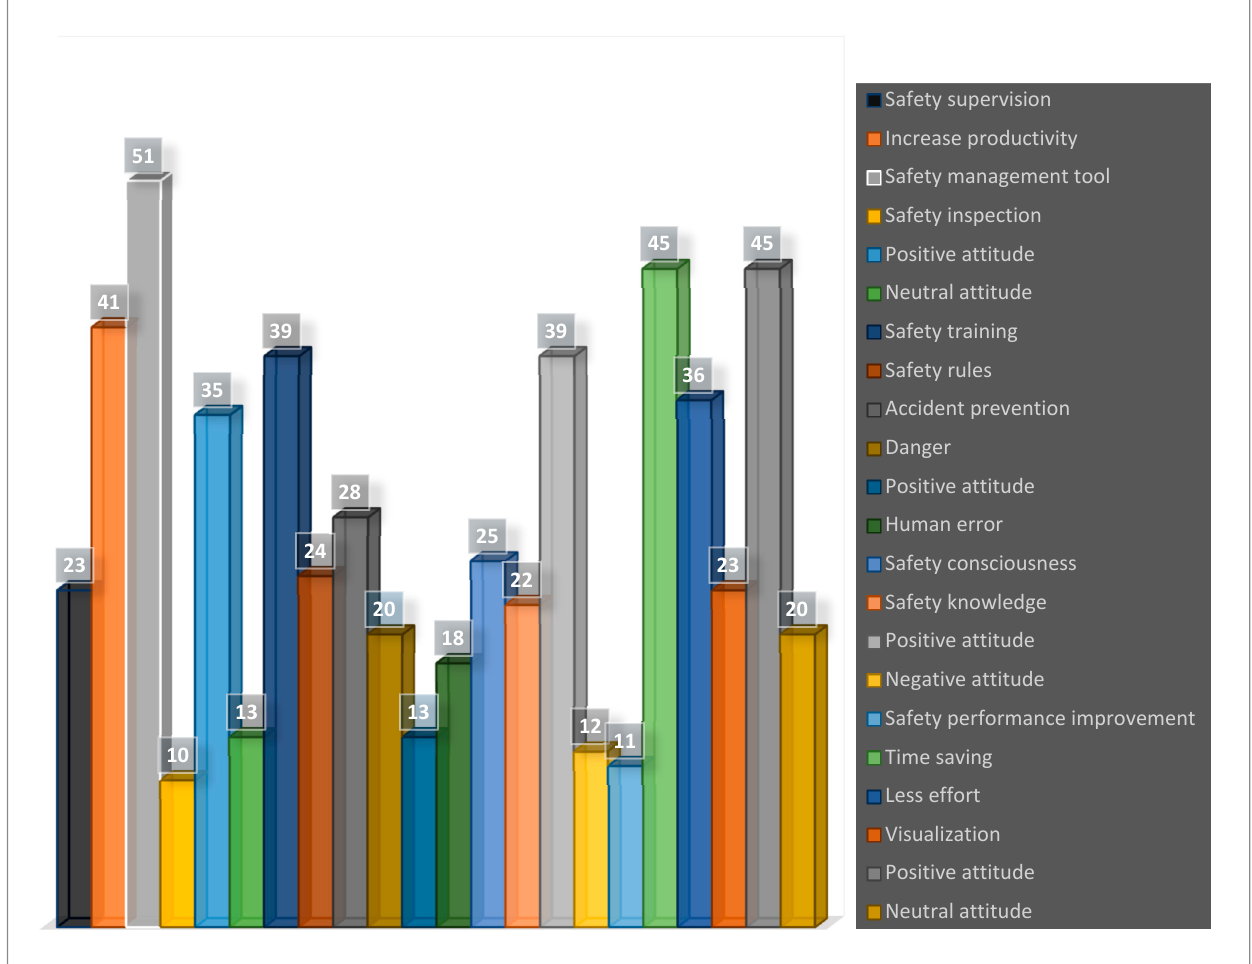
Figure 2. Coding scheme.